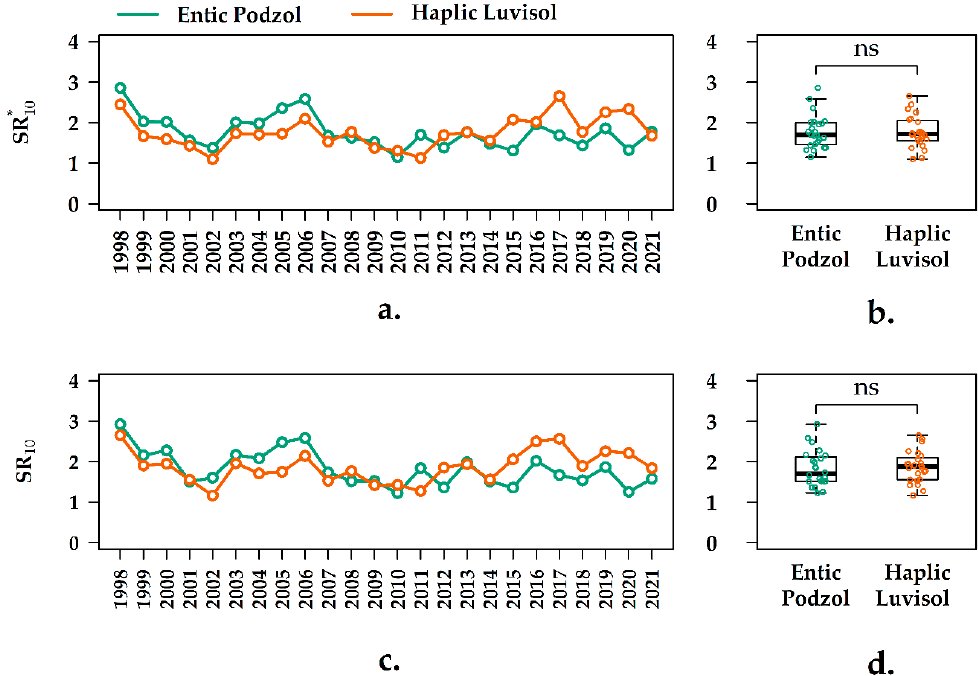
Figure 5. Dynamics of SR* 10 and SR 10 values (gCm − 2 day − 1 ) in the two forests during the observation period ( a , c ) and their statistical characteristics ( b , d ): the median (bar), lower (Q1) and upper (Q3) quartiles (“boxes”); X1 = Q1 − 1.5 IQR (interquartile range = Q3 − Q1) and X2 = Q3 − 1.5 IQR (“moustaches”). All data are shown as dots. ns—the difference between mean values is not significant. The values of SR 10 (for the interval of Ts ≥ 1 °C) for the studied soils changed in ranges which were similar to the corresponding SR* 10 values: from 1.15 to 2.86 gCm − 2 day − 1 in the sandy Entic Podzol and from 1.17 to 2.65 gCm − 2 day − 1 in the loamy Haplic Luvisol (Figure